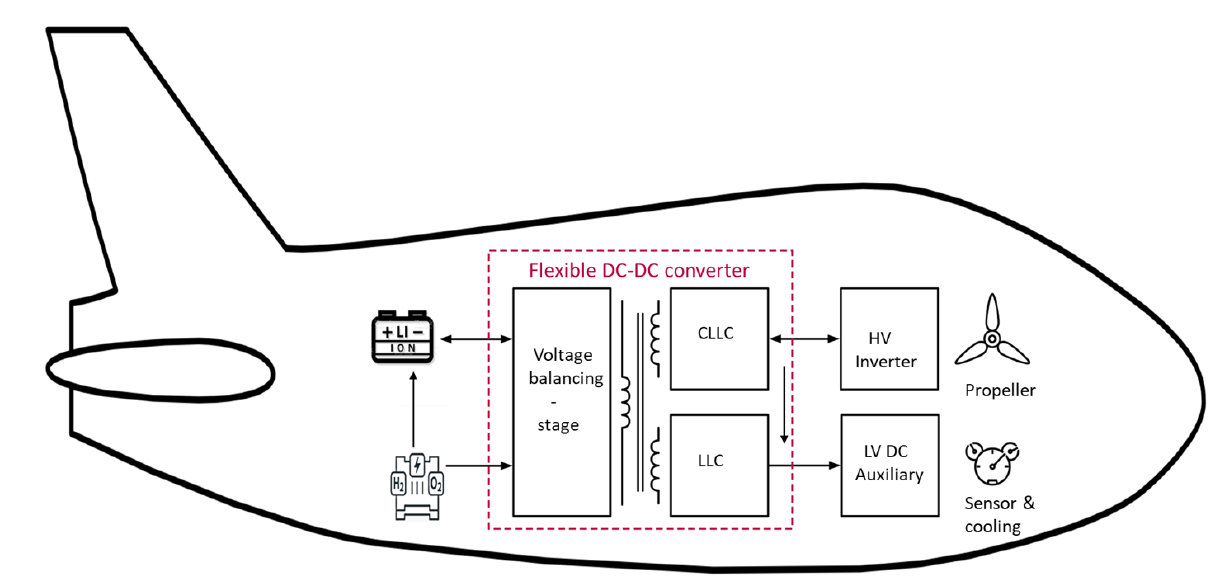
Figure 1. Proposed converter topology with power flow